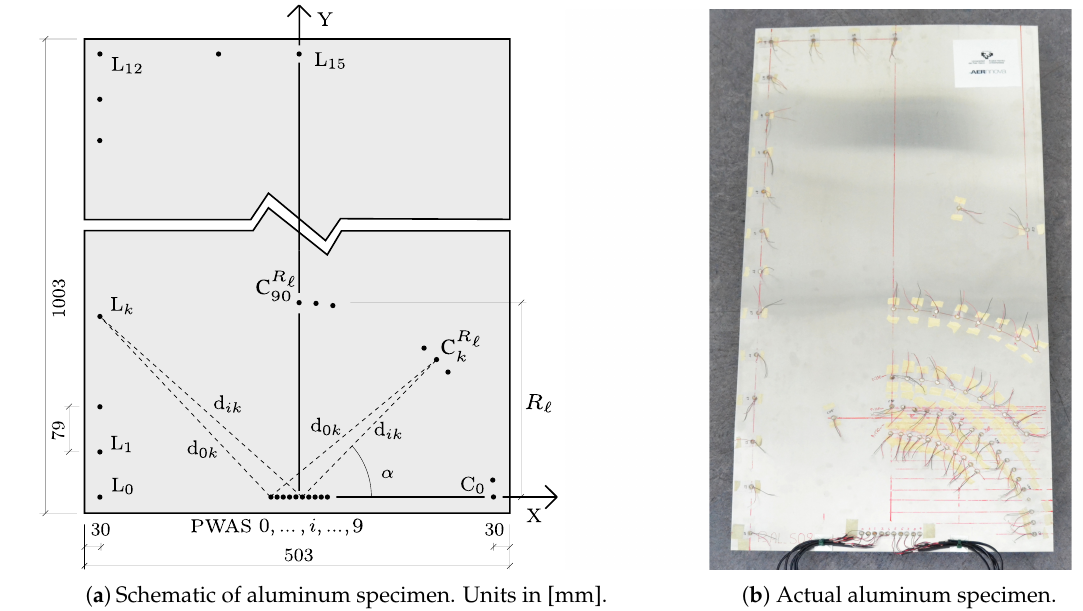
Figure 4. Aluminum specimen for transmission beamforming tests.